Question: What type of chart is this?
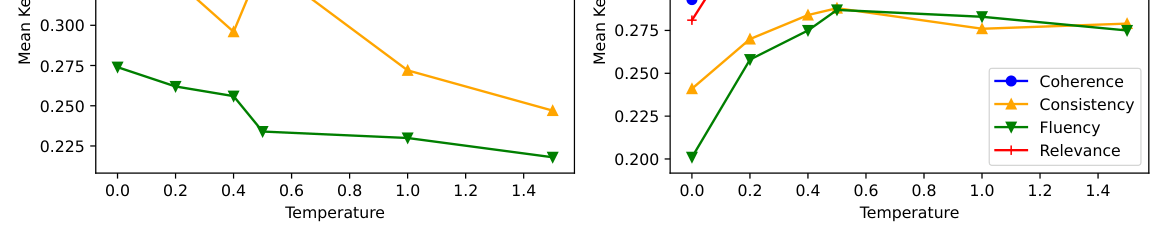
Answer: line